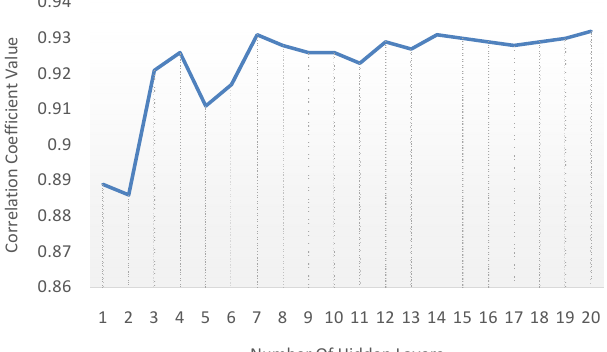
Fig. 3: Hidden layer selection using correlation coefficient Fig. 4: Hidden layer selection using correlation coefficient value